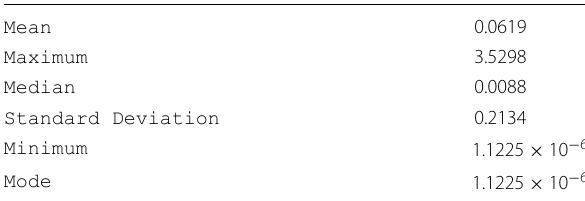
Table 2 Statistical Analysis of | J GNVR − J NPL